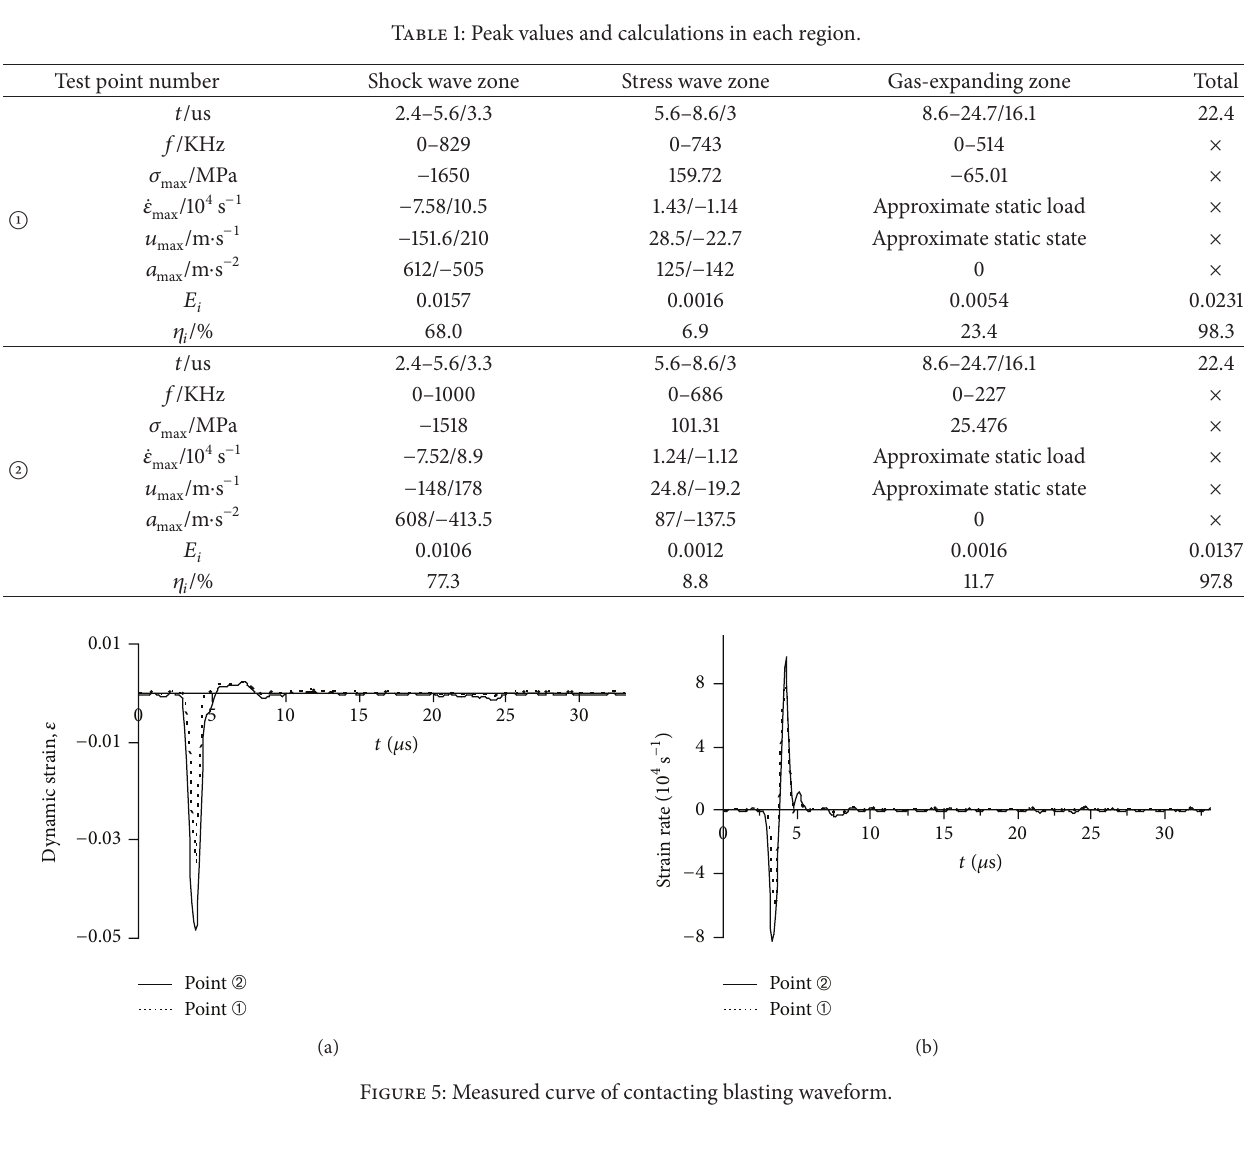
Table 1: Peak values and calculations in each region.